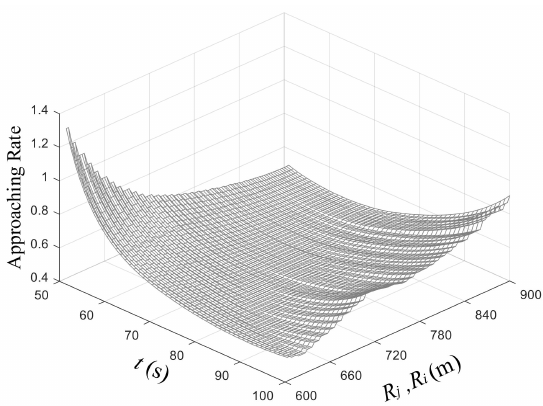
Figure 7. Trend Chart of the Approaching Rate of Two Aircraft with Time and Visual